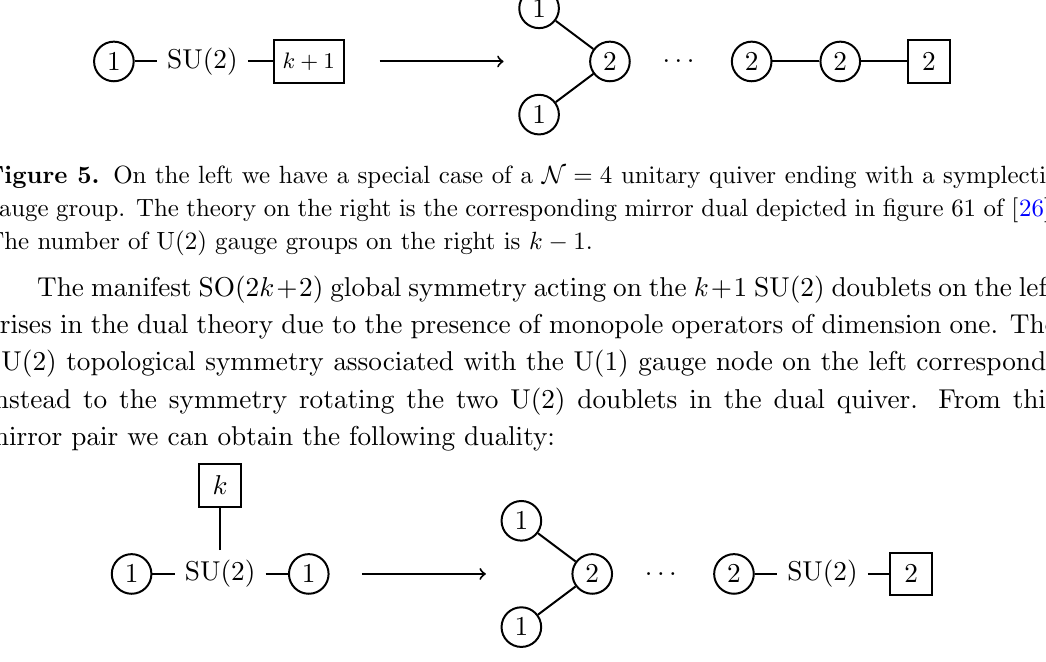
Figure 6. New N = 4 mirror pair obtained from the duality depicted in (cid:12)gure 5 by gauging the U(1) symmetry acting on one of the k + 1 fundamentals. The number of U(2) gauge groups on the right is k (cid:0)